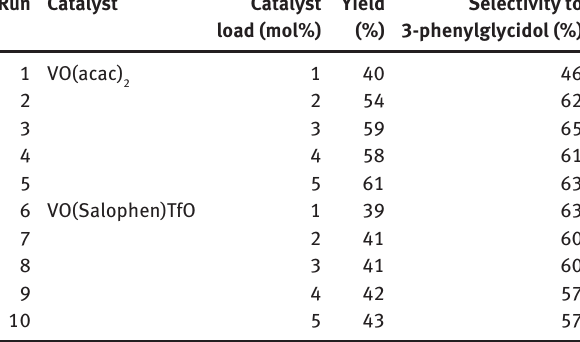
Figure 6 Vanadium catalysts: (A) VO(acac)